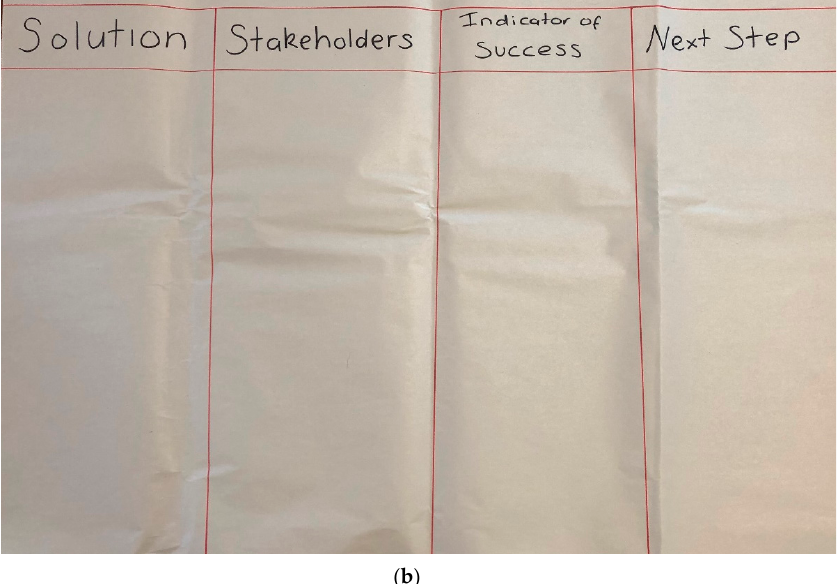
Figure 2. Pre-drawn ( a ) CLA template and ( b ) solutions table template used during FGDs.